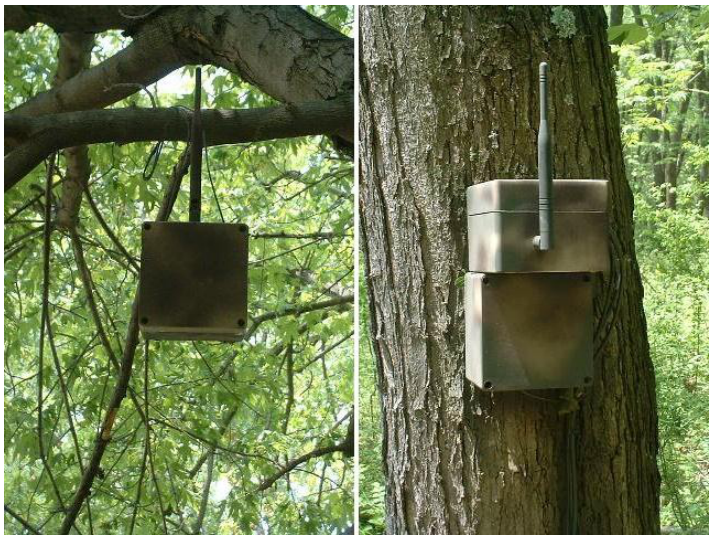
Figure 1. Examples of two WSN node configurations deployed at the ASWP